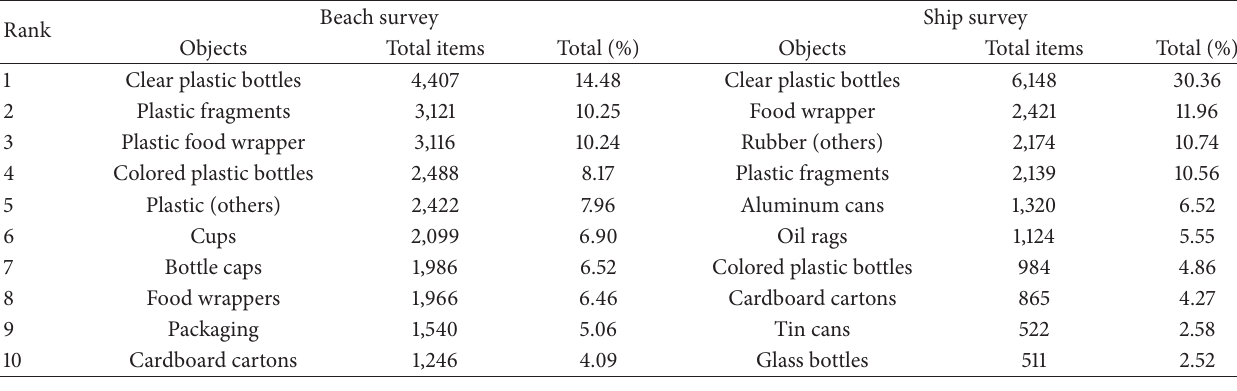
Table 2: Total items (number, item ) accumulated during beach and ship